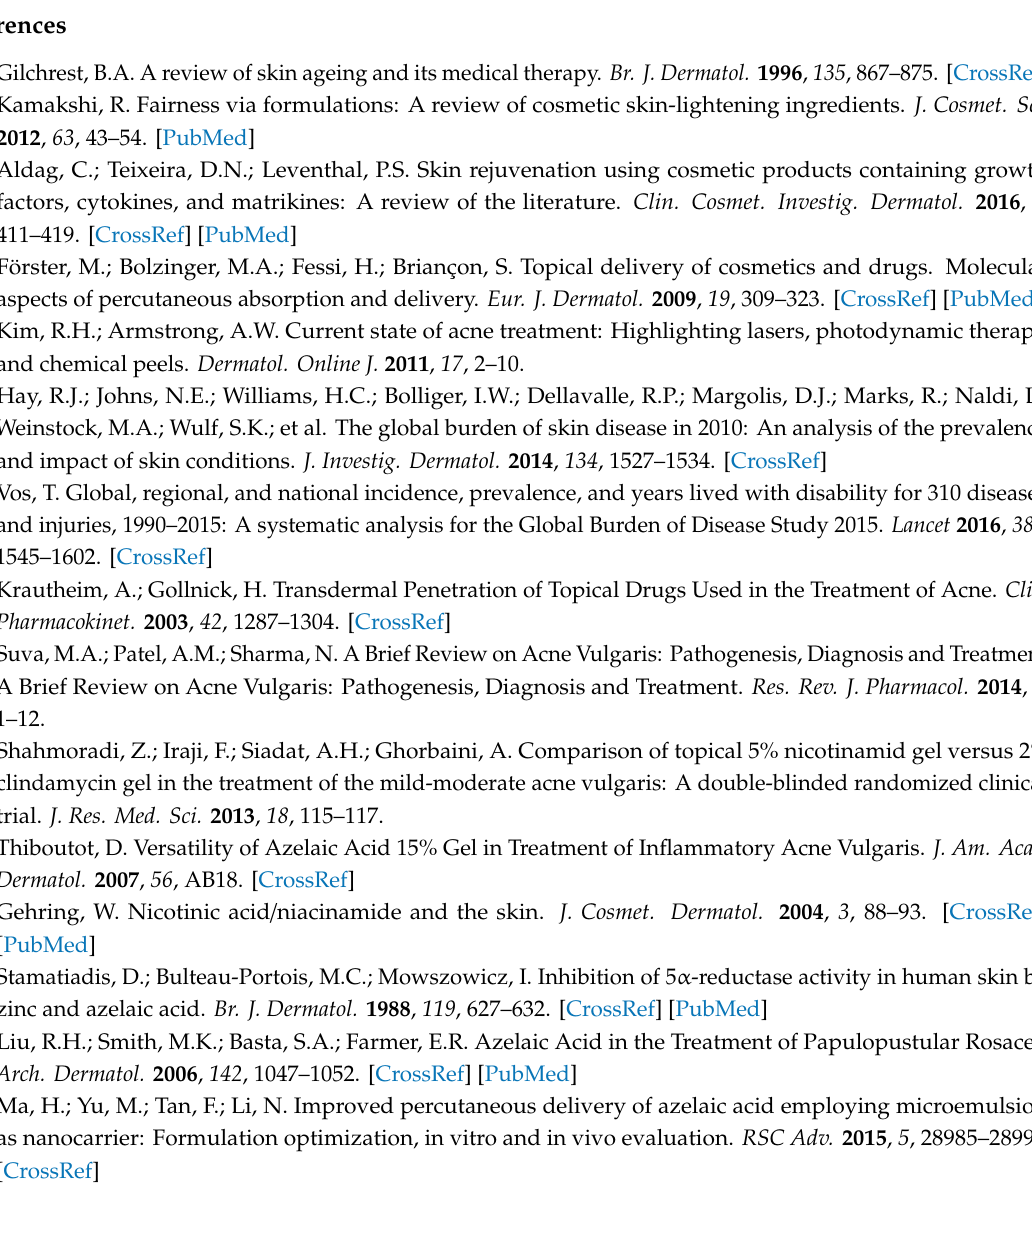
Figure S7: N 2 sorption studies, Figure S8: XRPD of one drug loaded materials, Figure S9: TGA of one drug loaded materials, Figure S10: FT-IR spectra of one drug loaded materials, Figure S11: Fitting of Nic and AzA delivery data, Figure S12: XRPD patters after drugs release process, Figure S13: XRPD patters of the prepared patches, Figure S14: Skin irritation test images, Table S1: Composition of the drugs loaded MOFs, Table S2: DLS characterization of pristine and drug loaded MOFs, Table S3: BET surface area and pore volume comparison, Table S4: Release kinetics, Table S5: composition of composite patches, Table S6: Di ff usion flux